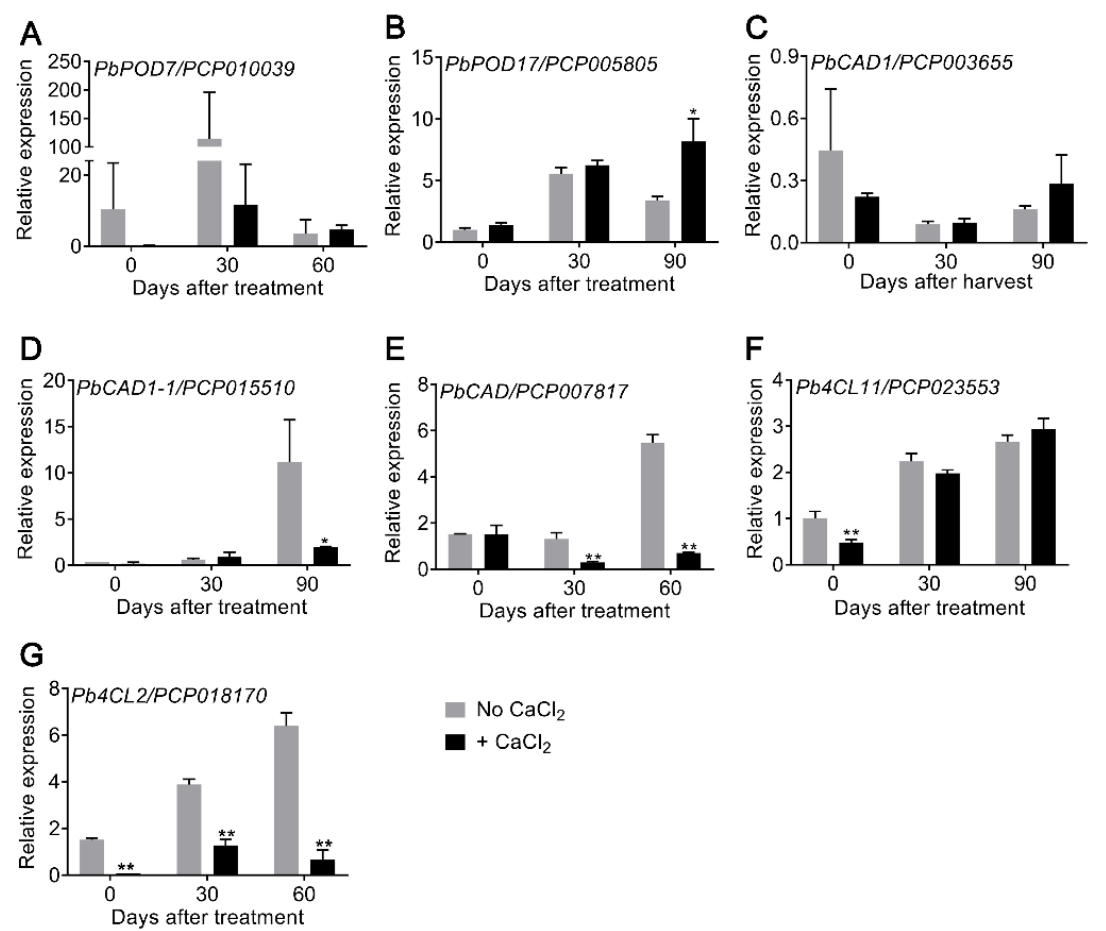
Figure 3. The expression pattern of lignin-related genes in pear fruit after CaCl 2 treatments. ( A – G ) The expression levels of lignin-related genes were verified by qRT-PCR. Data are given as mean ± SD (n = 3).